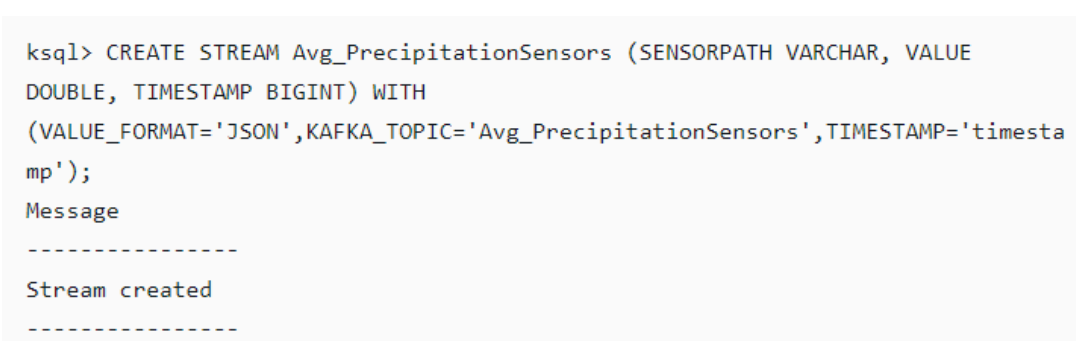
Figure 13. Topics created in the Kafka broker through the Confluent platform.